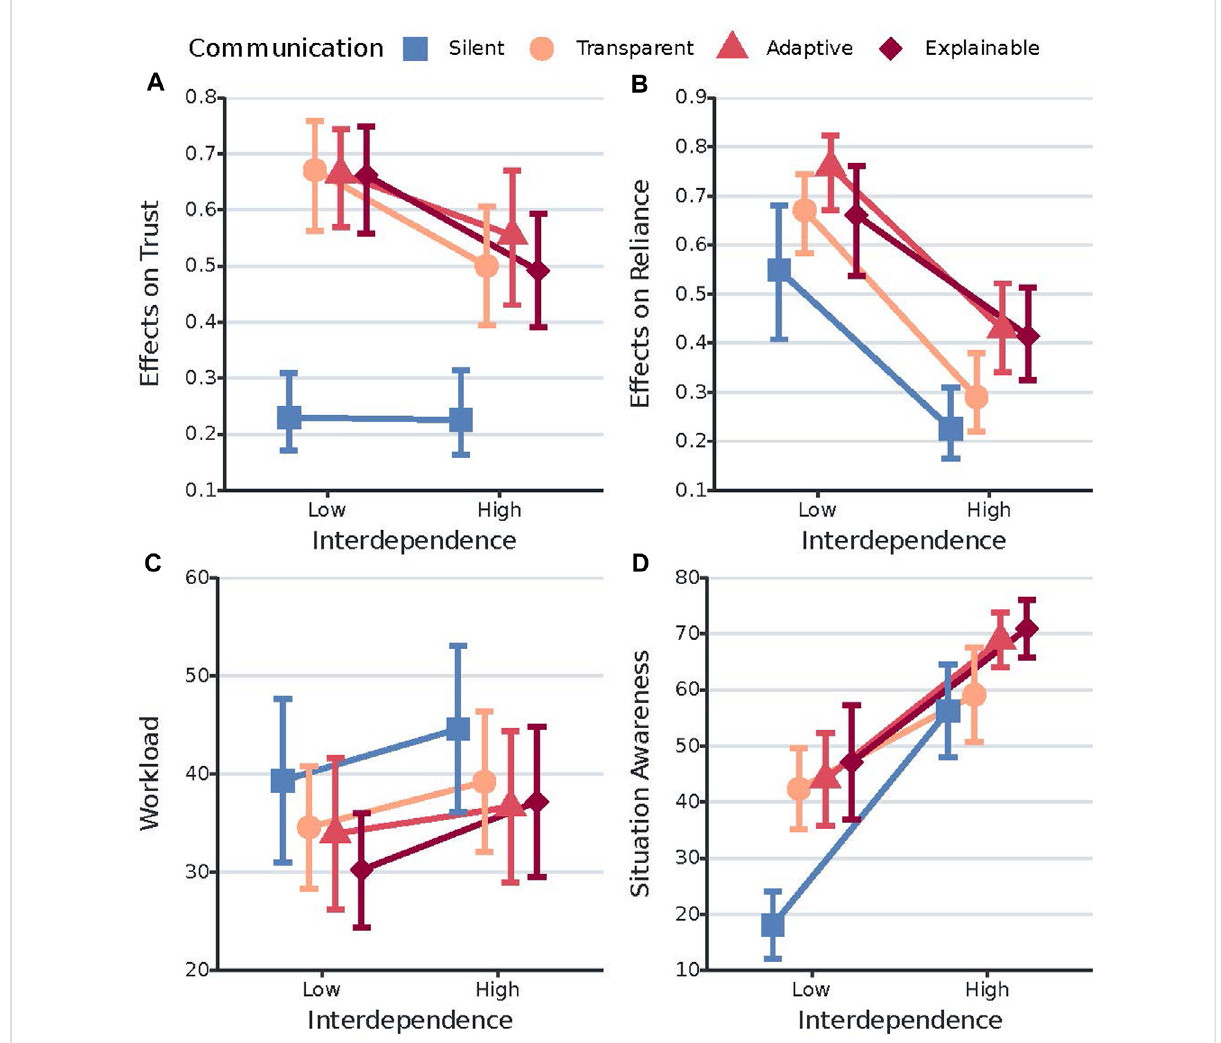
FIGURE 2 Interactionplotsoftheeffectsofcommunication styleandinterdependenceonthedependentvariablestrust,reliance, workload,andsituation awareness. (A) showstherelativetreatmenteffectsofcommunicationstyleontrustacrossinterdependence.They-axisistheconventionalgraphical representation of the non-parametric ANOVA we used. It represents the relative marginal effect of the different communication styles across interdependence. The higher is the value on the y-axis, the higher is the corresponding trust value/score. Error bars represent the 95% con fi dence intervals of the relative marginal effects. (B) shows the relative treatment effects of communication style on reliance across interdependence.Thehigheristhevalueonthey-axis,thehigheristhecorrespondingreliancepercentagevalue/score.Errorbarsrepresentthe95% con fi dence intervals of the relative marginal effects. (C) shows the effects of communication style on workload across interdependence. The y-axis represents the mean workload. Error bars represent the 95% con fi dence intervals of the mean workload scores. (D) shows the effects